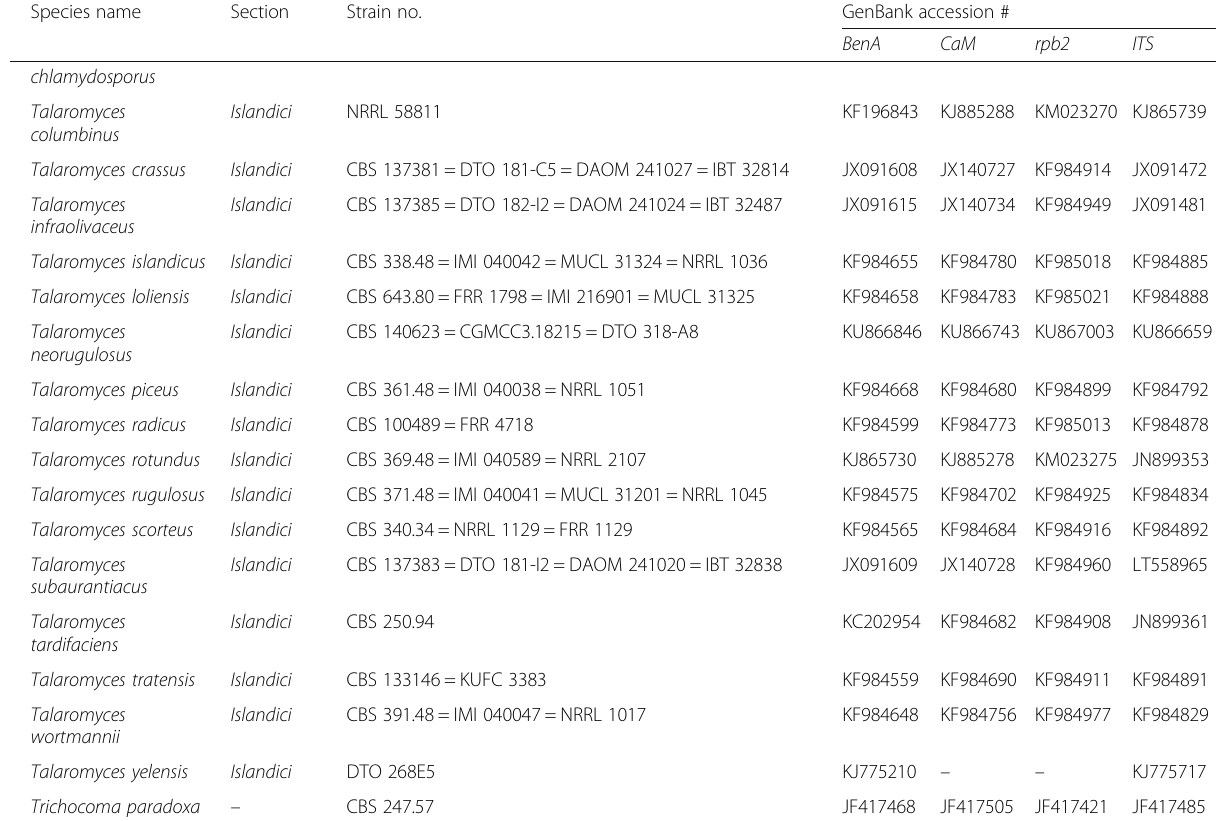
Table 2 Talaromyces spp. nucleotide sequences employed to build a phylogram to locate phylogenetically our strains from honey